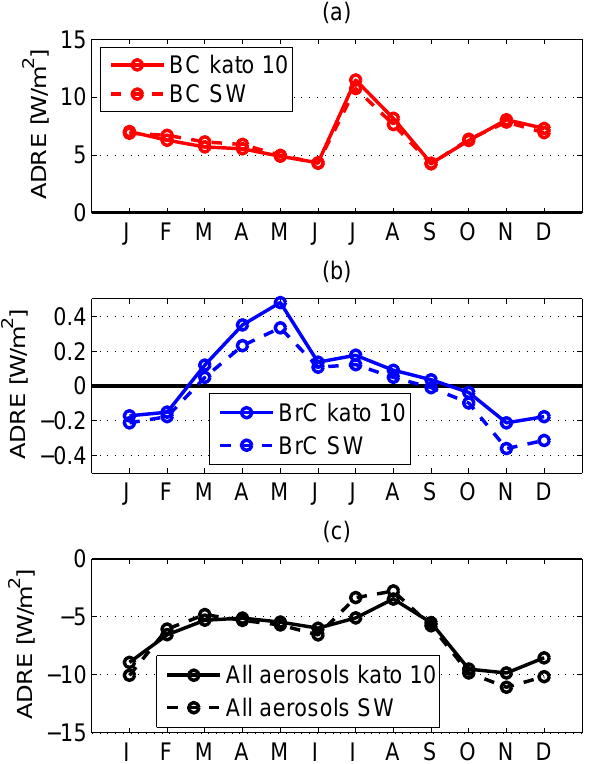
Figure 7. Direct radiative effect in Kanpur based on two spectral ranges of Kato bands: (1) all Kato bands and (2) Kato band no. 10 (center wavelength at 544.8nm), but scaled to account for the full SW range. Upper panel: for BC; middle panel: for BrC; lower panel: for total